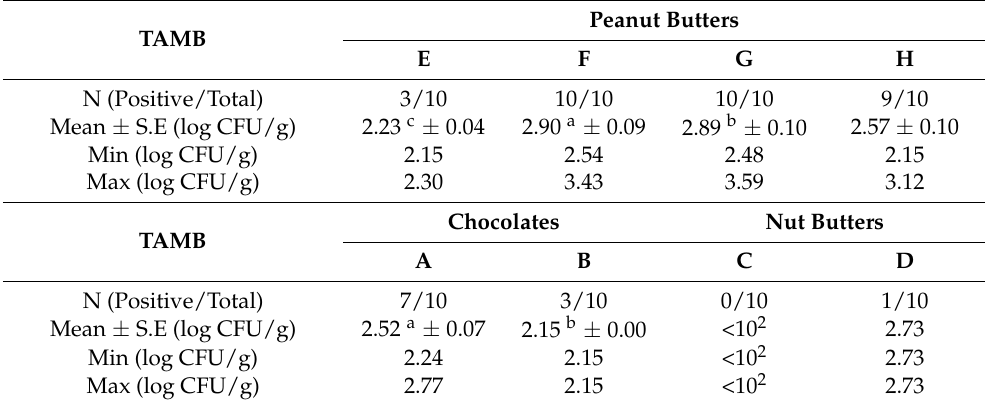
Table 5. Mean ± S.E, as well as the min and max TAMB values of brands of chocolates, hazelnut, and peanut